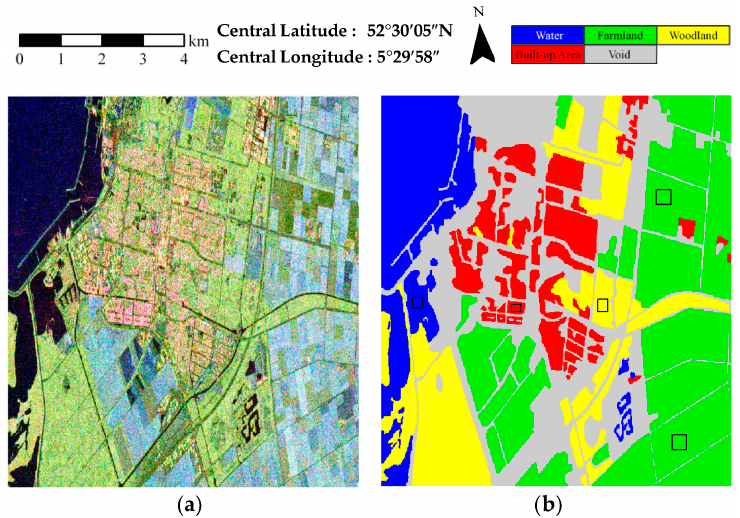
Figure 6. C-band, multi-look PolSAR image of Flevoland of RADARSAT-2 as the second dataset used in the experiment: ( a ) Pauli color-coded image and ( b ) the ground truth map of ( a ). Boxes in ( b ) are the areas of training samples for the RADARSAT-2 data.